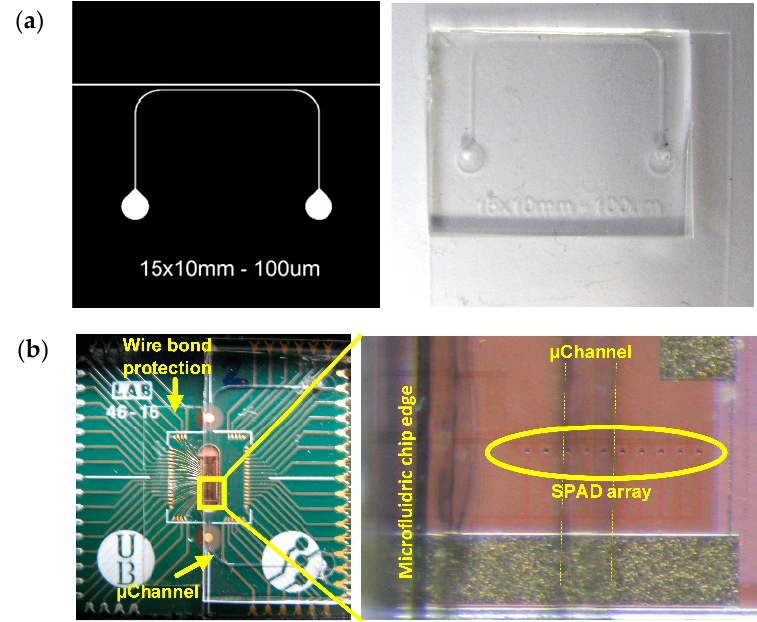
Figure 6. ( a ) Microfluidic design and final cartridge; ( b ) Microfluidic cartridge over the encapsulated chip with a detail of the microchannel over the SPAD array.